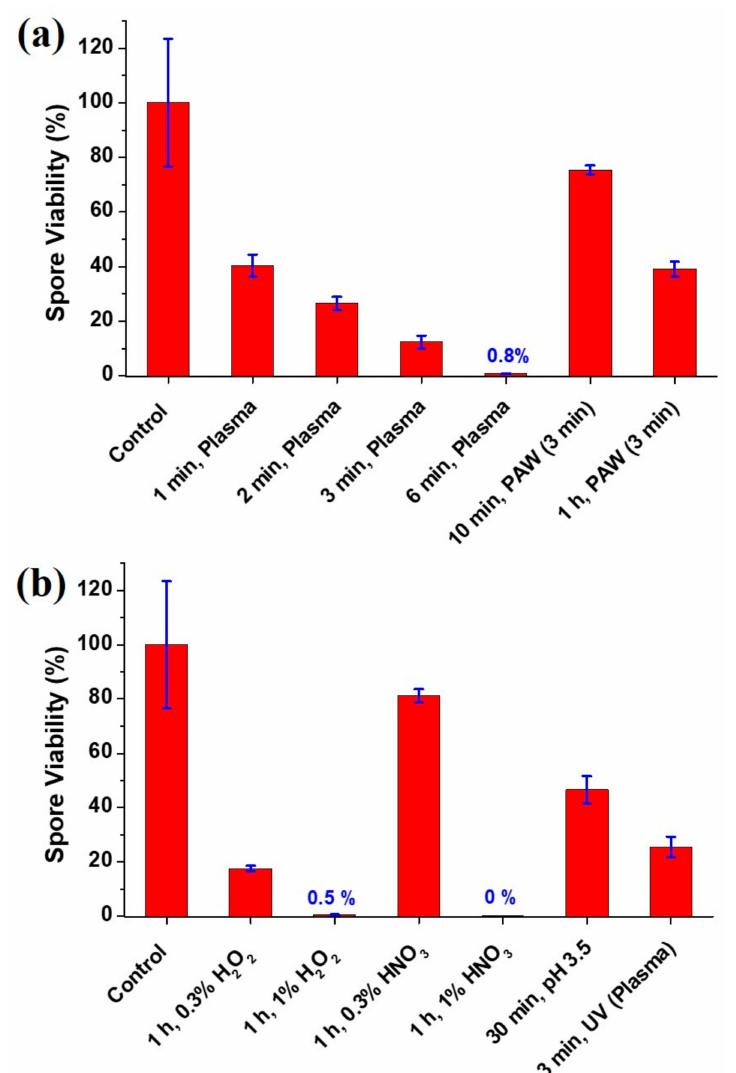
Figure 2. ( a ) Viability of the C . pruinosa spores treated by the atmospheric-pressure air plasma jet (soft plasma jet). The 1st, 2nd, 3rd, 4th, and 5th bars of Figure 2a represent the viability of the control, 1 min, 2 min, 3 min, and 6 min plasma-treated C . pruinosa spores, respectively. ( b ) Viability of the C . pruinosa spores treated by H 2 O 2 solutions, HNO 3 solutions, acid water, and UV light. The 6th and 7th bars of Figure 2b represent the viability of C . pruinosa spores treated by acid water of pH 3.5 and plasma-generated UV light,